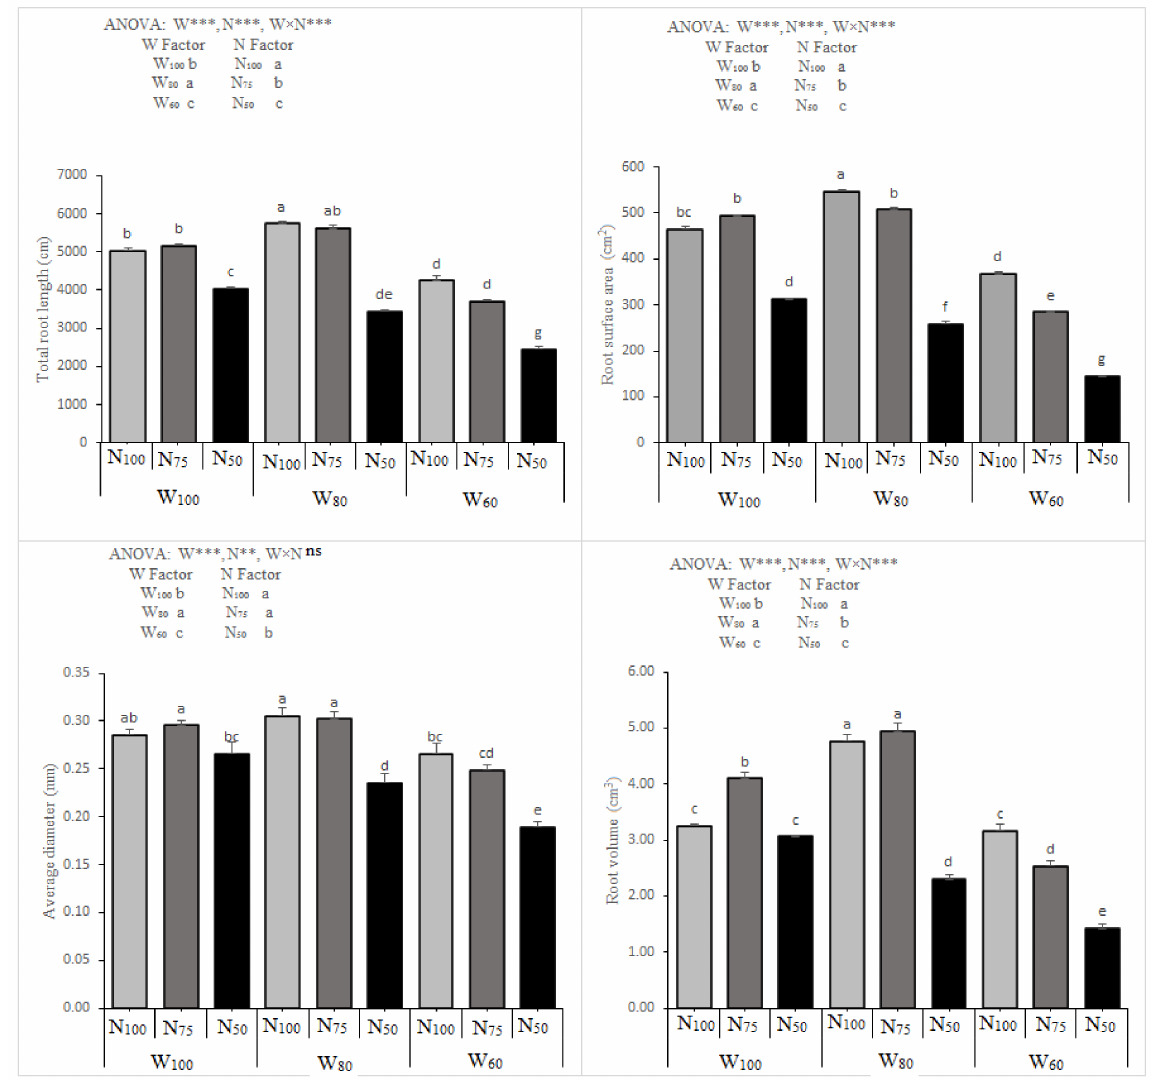
Figure 2. Effects of irrigation water (W) and nitrogen fertilization (N) on tomato total root length, root surface area, average diameter, and root volume at the harvesting stage during fall–winter. Bars with different letters are significantly dif-ferent at p < 0.05 according to LSD test. ***, ** indicate significance at p < 0.001 and p < 0.01, respectively, and ns indicates non-significance ( p >